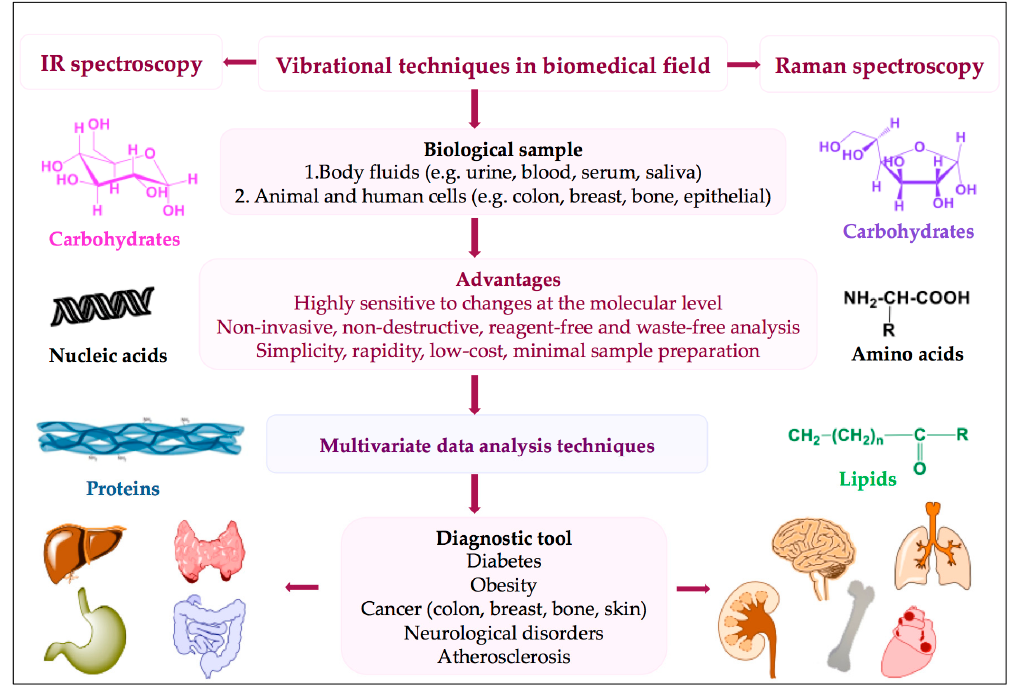
Figure 3. Strategy in biomedical applications.